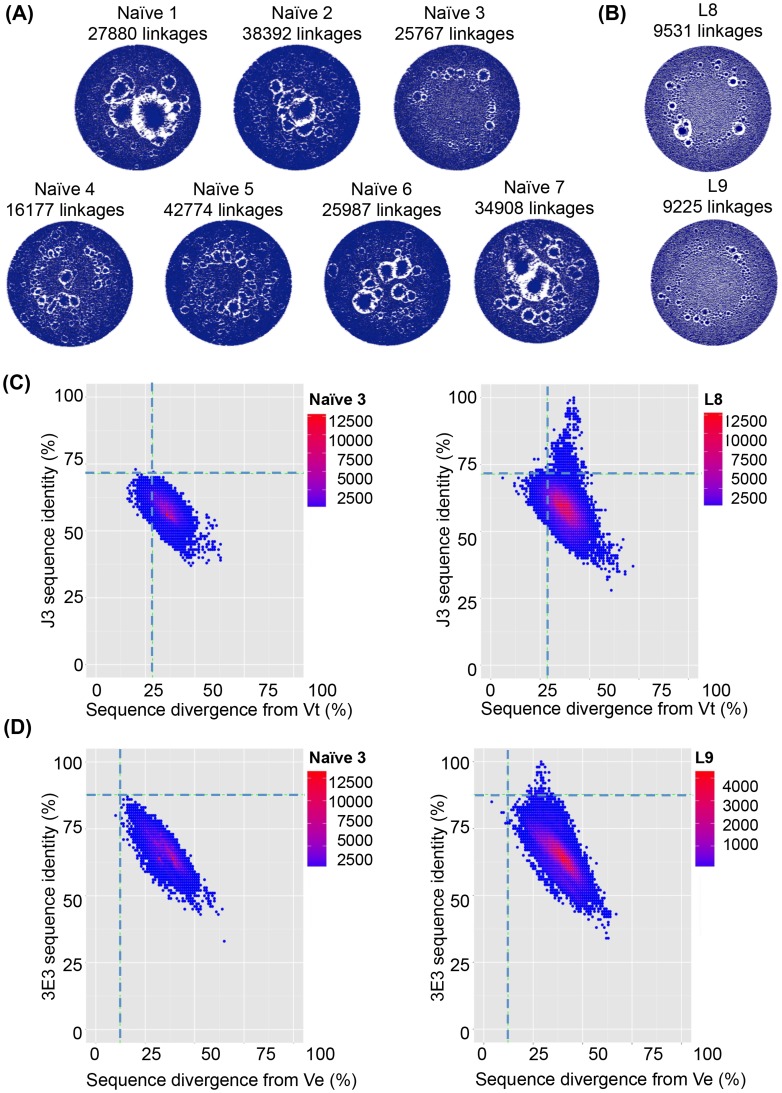
VHH repertoires of naïve and protein-immunized llamas.VHH sequences from immunized llamas 8 and 9 and seven naïve llamas were amplified from their respective phagemid libraries by PCR using primers specific to the 5′ and 3′ conserved regions of the VHH and subjected to 454 sequencing. (A) Unique sequences generated from the indicated llama phage library were used to build end-joining network diagrams with significantly more linkages (P = 0.001) in the naive llamas versus (B) immunized llamas. (C) Shared percentage identities with neutralizing VHH J3 and divergence from its inferred V gene Vt were calculated for all unique sequences from the control naïve llamas, and the J3-source llama 8. The left hand panel shows percentage identity for all sequences from naïve 3 plotted against divergence from Vt. The right panel shows percentage identity for all sequences from llama 8 plotted against divergence from Vt. The horizontal dotted line on each panel indicates the percentage identity shared by Vt and J3 and the vertical dotted line indicates the divergence of J3 from Vt, (D) Shared percentage identities with neutralizing VHH 3E3 and divergence from its inferred V gene Ve were calculated for all unique sequences from the control naïve llamas, and the 3E3-source llama 9. The left hand panel shows percentage identity for all sequences from naïve 3 plotted against divergence from Ve. The right panel shows percentage identity for all sequences from llama 9 plotted against divergence from Ve. The horizontal dotted line on each panel indicates the percentage identity shared by Ve and 3E3 and the vertical dotted line indicated the divergence of 3E3 from Ve.